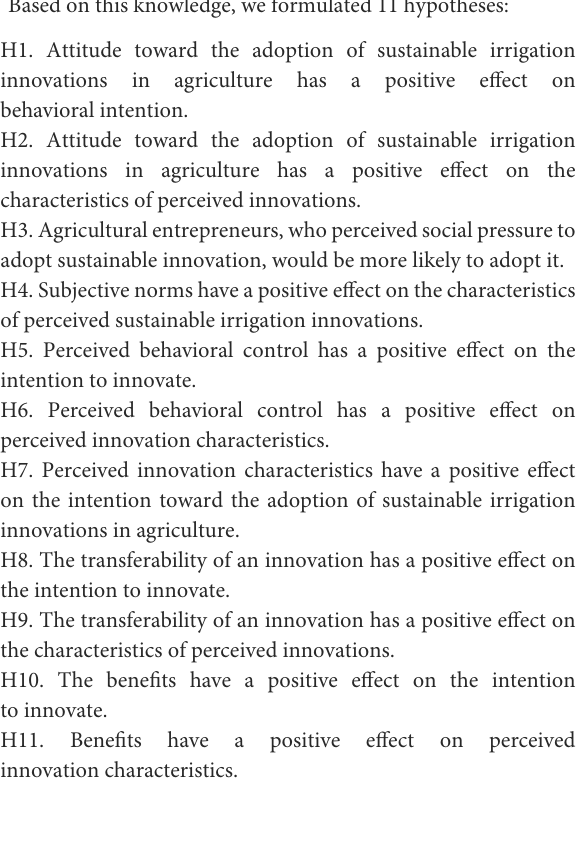
system: relative advantage, compatibility, complexity, observability and trialability. All these factors influence the decision to adopt or not to adopt technological innovation (Figure